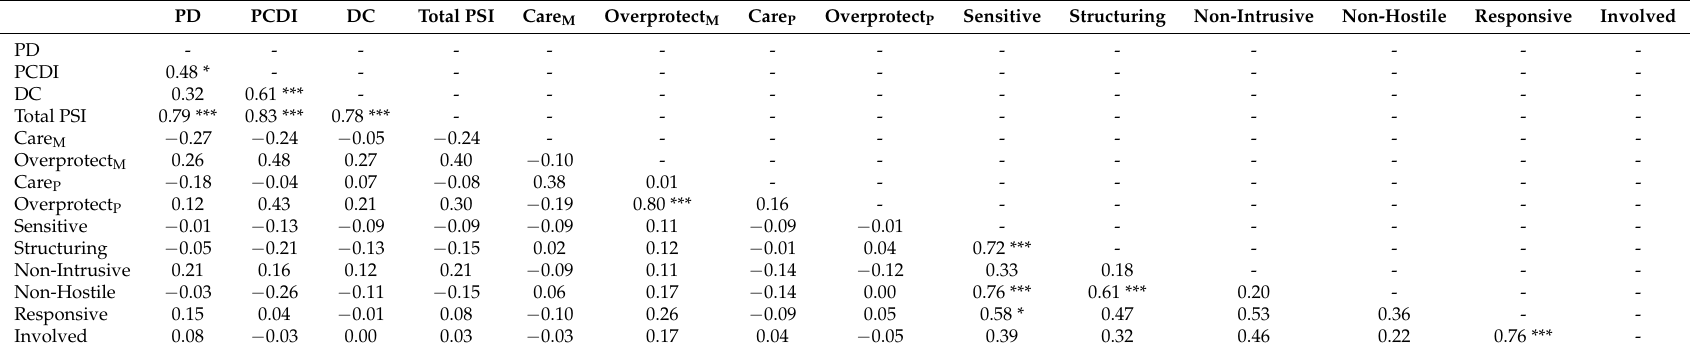
Table 2. Inter-correlation coefficients between different subscales of the Parenting Stress Index (PSI), the Parental Bonding Instrument (PBI) and the Emotional Availability Scale (EAS). Notes. PD = parental distress, PCDI = parent-child dysfunctional interaction, DC = difficult child, Total PSI = total parenting stress score, Care M = maternal care, Overprotect M = maternal overprotection, Care P = paternal care, Overprotect P = paternal overprotection, Sensitivity = adult sensitivity, Structuring = adult structuring, Non-Intrusive = adult non-intrusiveness, Non-Hostile = adult non-hostility, Responsive = child responsiveness, Involved = child involvement. * p ≤ 0.05, *** p ≤ 0.001 (Bonferroni